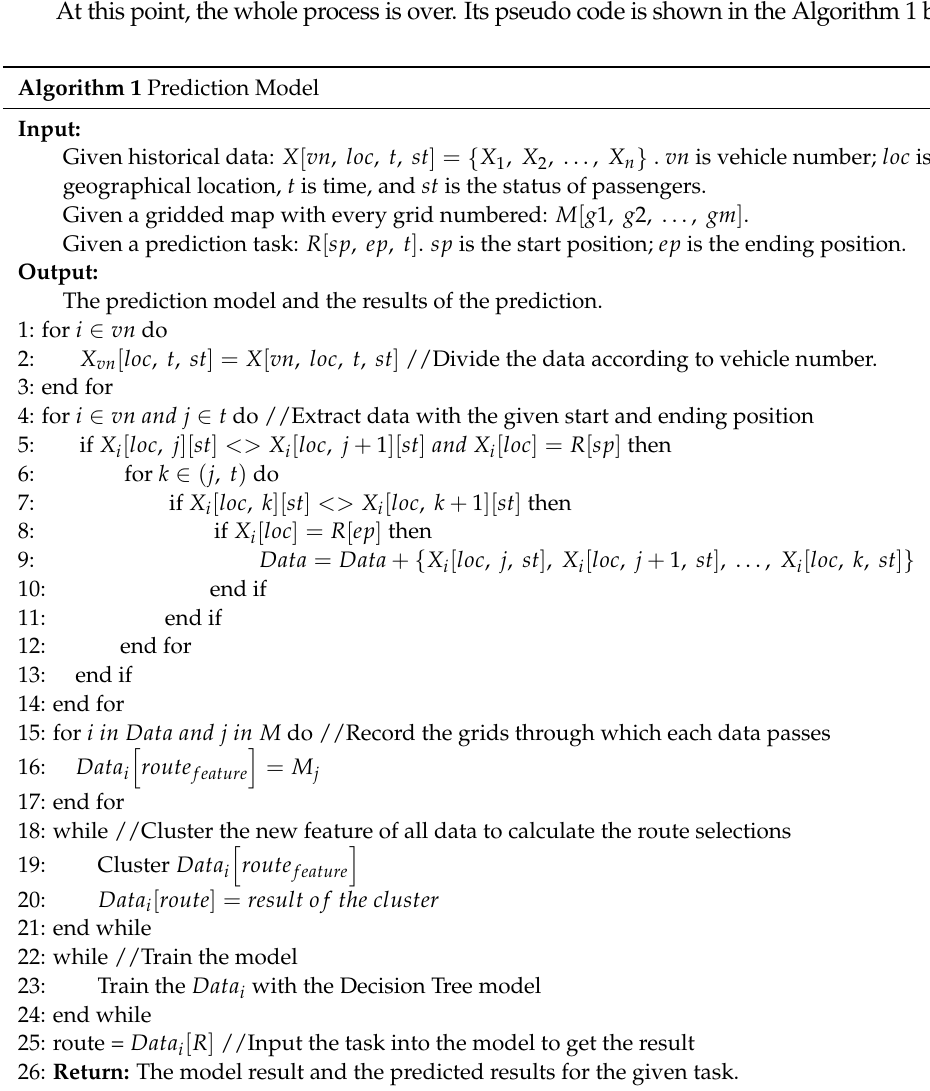
Algorithm 1 Prediction